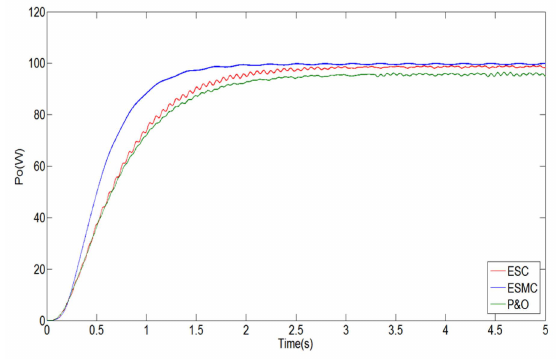
Figure 9. Comparisons of the output power of three control